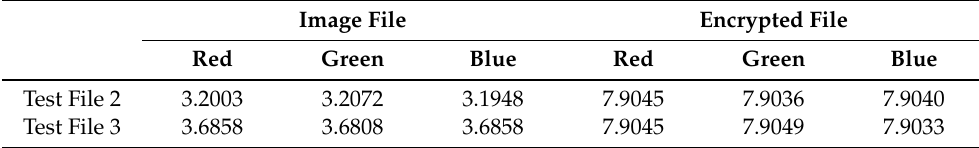
Table 3. Local entropy for plaintext and encrypted image versions of the text